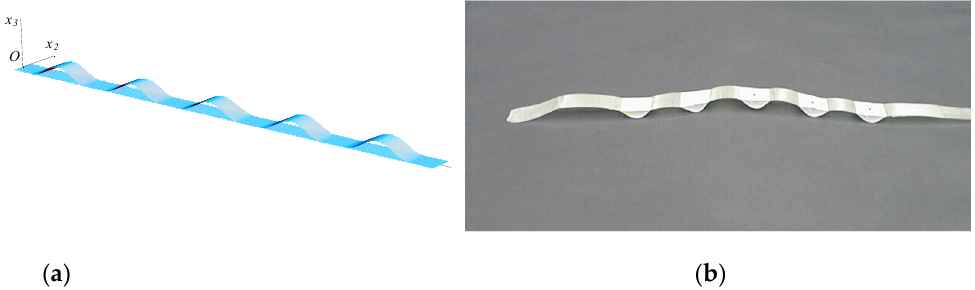
Figure 2. A schematic concept of a tether structure ( a ) and its physically manufactured example ( b ).